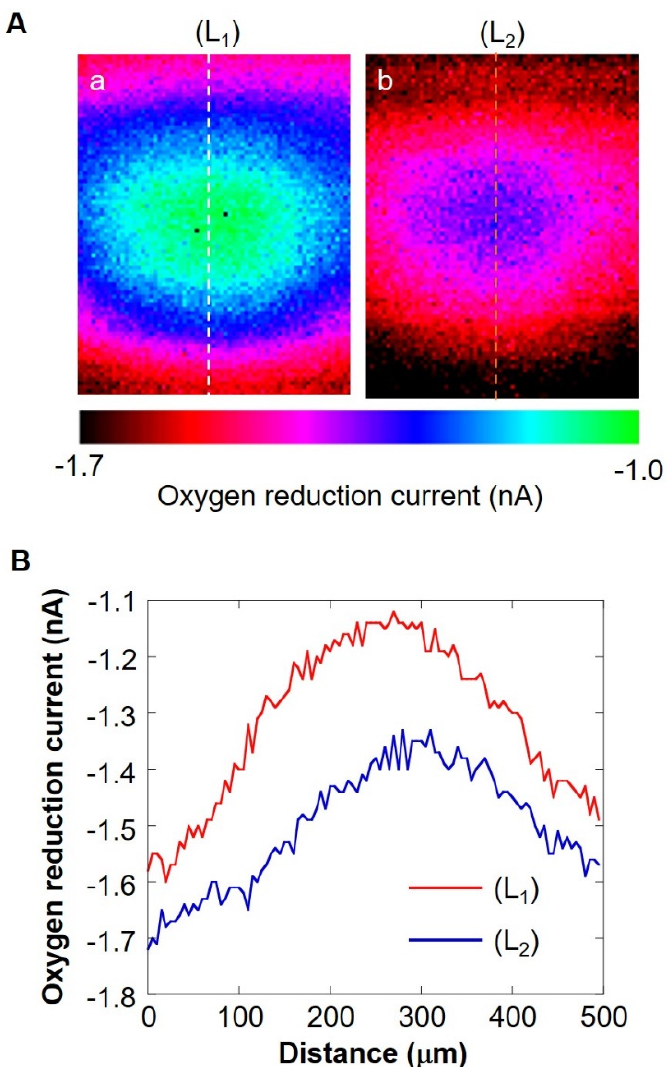
Figure 6. ( A ) XY-scan images showing the oxygen concentration distribution with the distance between Pt microelectrode and the cell chip of 30 µ m ( a ) and 160 µ m ( b ). Line (L 1 ) and (L 2 ) are on the same X coordinate. Graph ( B ) shows the oxygen reduction current values of line (L 1 ) and line (L 2 ). Since the oxygen diffusion layer on the milk cell chip is hemispherical, we con- sidered f as the oxygen diffusion flux (mol/cm 2 ), D as the oxygen diffusion coefficient (2.18 × 10 − 5 cm 2 /s), and C as the oxygen concentration of the surface (mol/cm 3 ). C* is